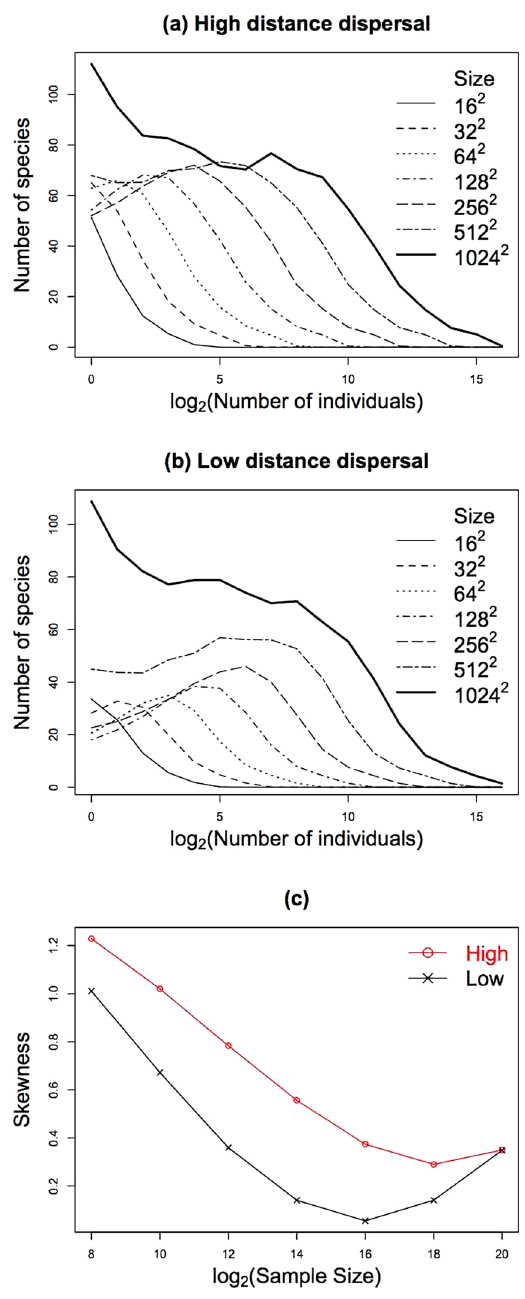
Figure 1. The SADs as a function of sample size obtained with computer simulations: ( a ) high dispersal ability and ( b ) low dispersal ability. In the computer simulations each individual occupied a cell in a landscape modelled as a matrix of 1024 × 1024 elements. Thus sample size (the numbers in the right side of the figure) can be interpreted as the number of individuals or area size (e.g., “16 2 ” means a sample of 16 × 16 elements (or individuals, or size) of the landscape. Except for the largest size (1024 2 ) each curve is the average obtained from all samples with the same size. Each sample is a set of adjacent points in a matrix forming a square. The x-axis corresponds to classes of the logarithm of the number of individuals as follows: 1 individual, 2 to 3 individuals, 4 to 7 individuals, et seq . Plot ( c ) shows the skewness of the high (red) and low (black) dispersal ability distributions as a function of sample